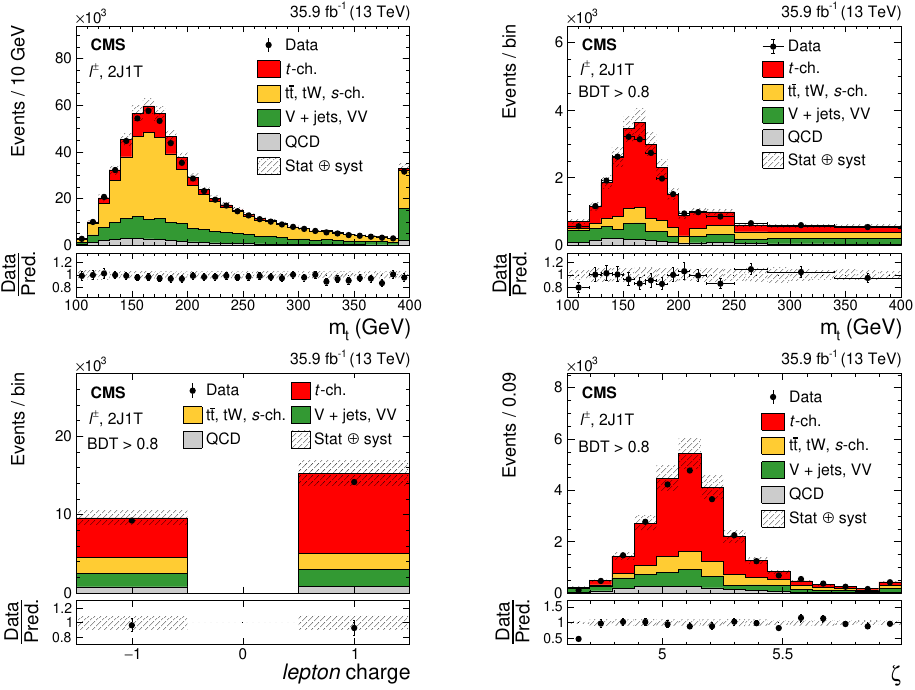
distributions before (upper-left) and after (upper-right) applying the Figure 6 . Reconstructed m t optimized BDT selection from data (points) and simulation (colored histograms) are shown in the upper row. The lower-left plot shows the event yields per lepton charge in data and simulation after optimized BDT selection. Data-to-simulation comparison of the fit variable ζ = ln( m / 1 GeV ) in- t clusive of lepton charge after optimized BDT selection is presented in the lower right plot. The hori- zontal bars in the upper-right plot indicate the variable bin width. The first and last bins include the underflow and overflow, respectively, for each plot. The bands denote a quadrature sum of the sta- tistical and systematic uncertainties in the prediction. The lower panels show the ratio of the data to the prediction. The deviation from unity seen in the first bins of the upper-right and lower-right ra- tio plots arises because of significantly less underflow events in the data compared to the